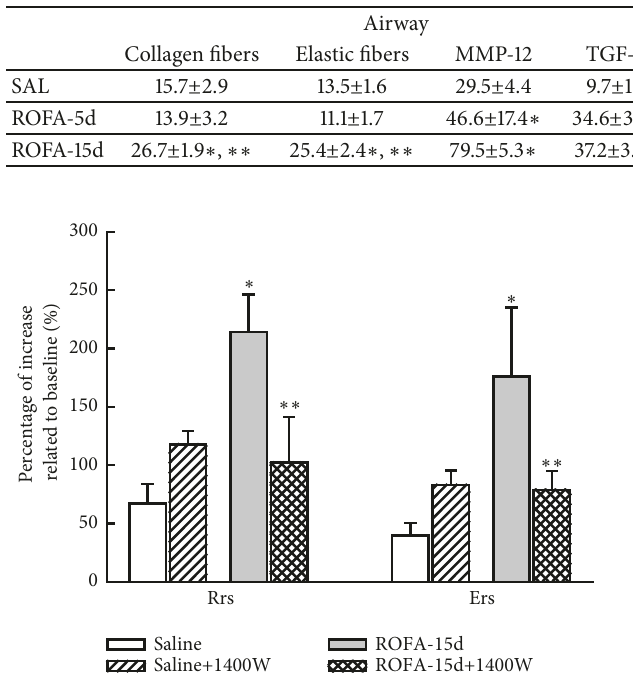
Figure 1: Lung mechanics.This figurerepresentsthe mean and SEM percentage of maximal increase of respiratory system resistance (Rrs) and elastance (Ers) relative to baseline. The animals that receivedfifteeninstillationsofROFApresentedhighervaluesofboth Rrs and Ers compared to control and 1400W treatment reduced this response. ∗ p < 0.05 compared with saline groups; ∗∗ p < 0.05 compared with animals that received ROFA and vehicle